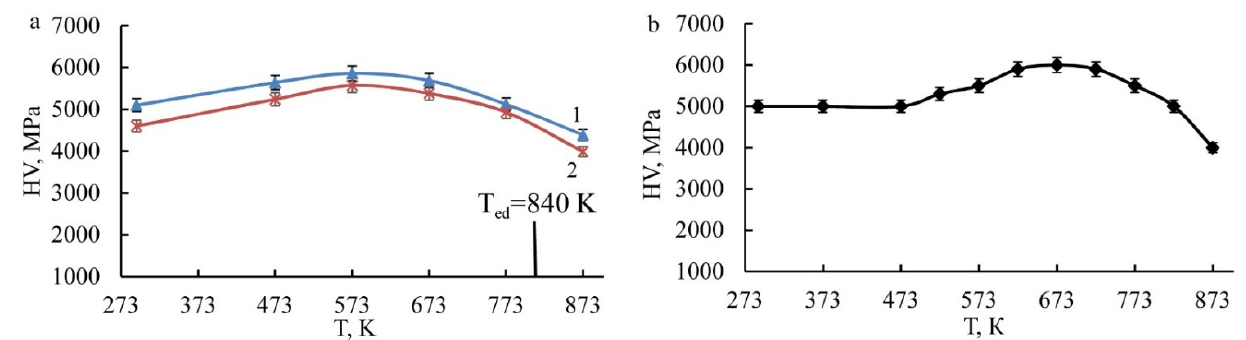
Figure 32. Microhardness H V (MPa) of the HPT-treated alloys ( a ) Cu–14Al–3Ni (curve 1–quenching from 1223 K, curve 2–quenching from 1273 K) and ( b ) Cu–13.5–3.5Ni depending on annealing temperature for 30 min [64].